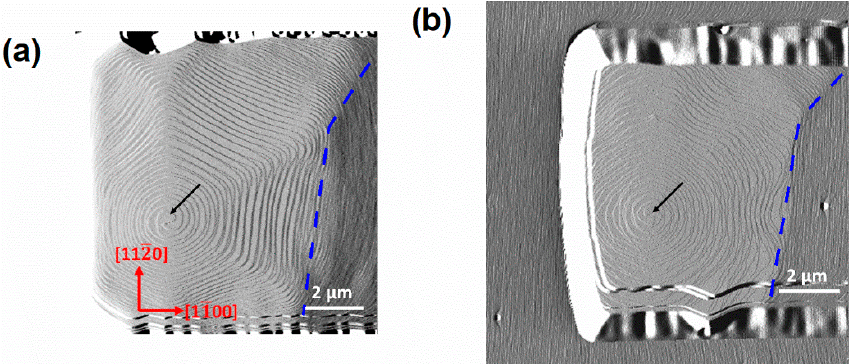
Figure 4. AFM amplitude images on the upstream edge of the 10 μ m-wide stripe along the m- direction for sample A: ( a ) 10 × 10 μ m 2 and for sample B: ( b ) 12 × 12 μ m 2 . The black arrows point to the apex of screw dislocations.